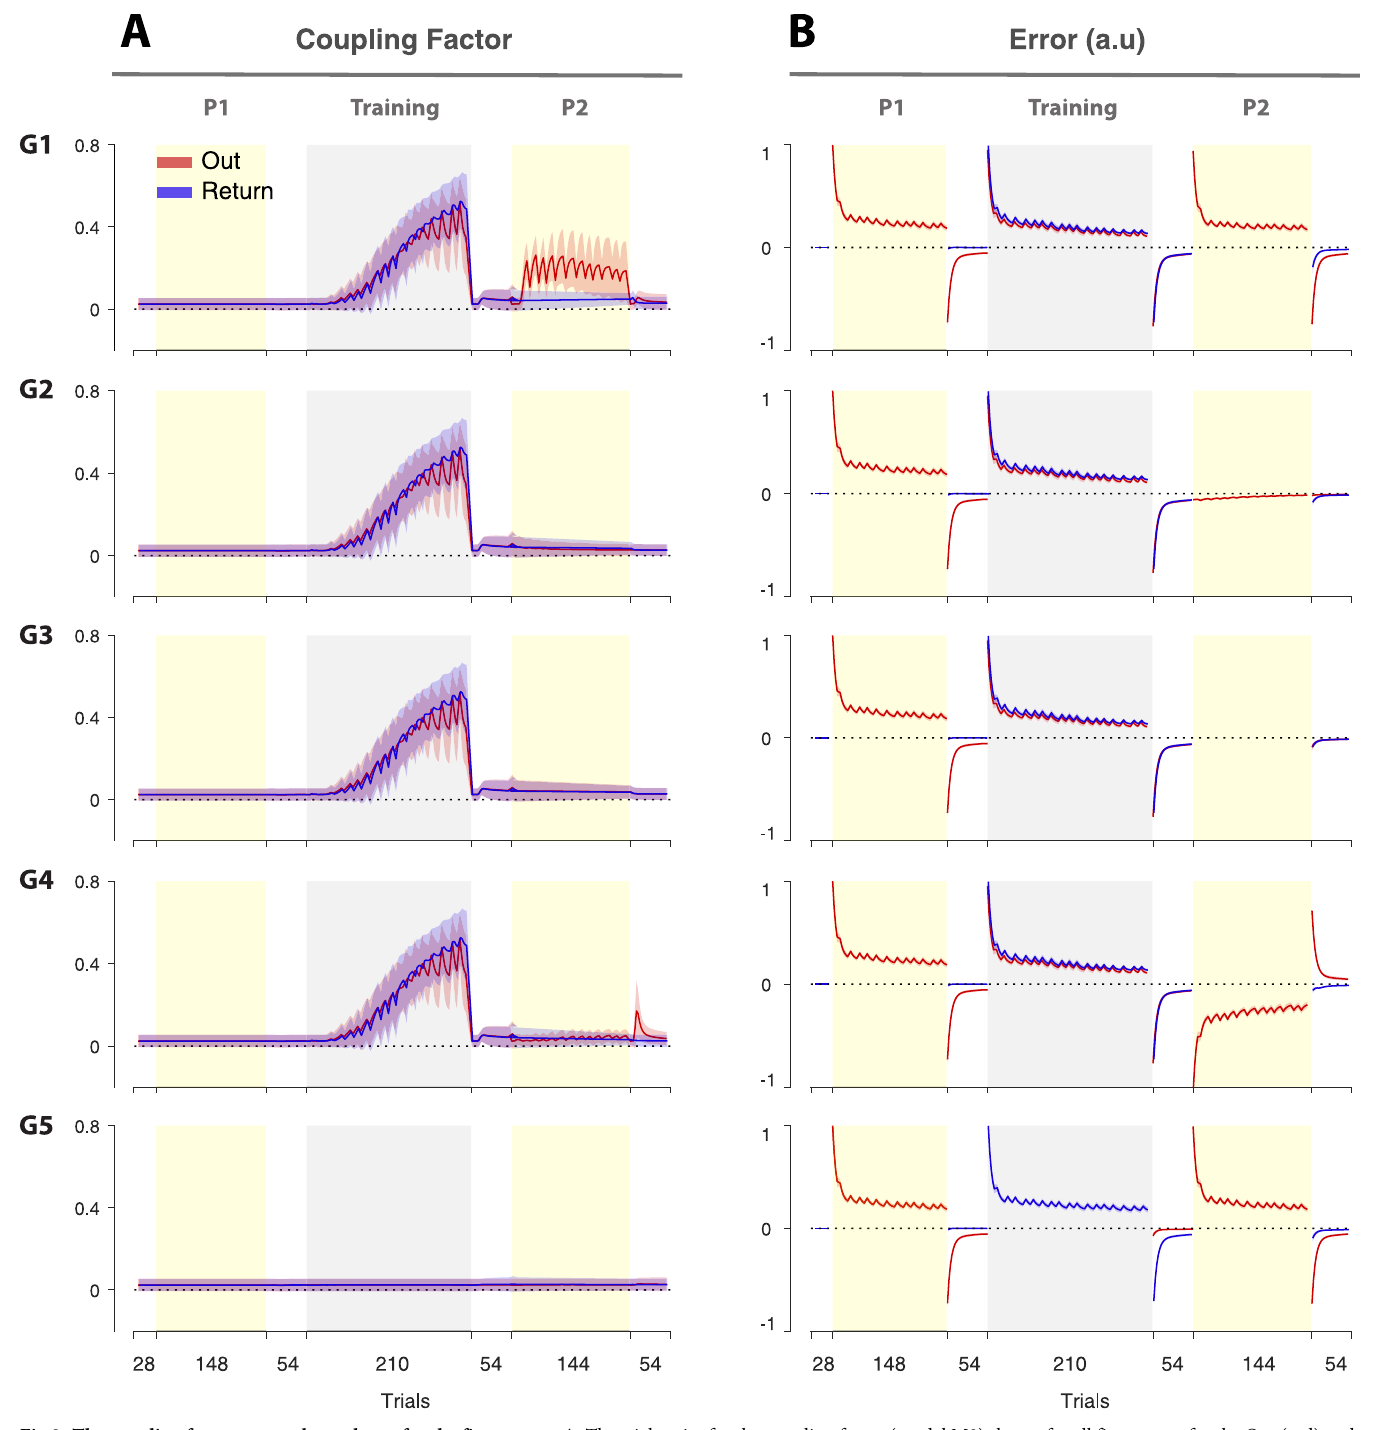
Fig 8. The coupling factor across three phases for the five groups. A . The trial-series for the coupling factor (model M8) shown for all five groups for the Out (red) and Return (blue) movements. The error bars represent the 95% confidence intervals, obtained by bootstrapping. B . The trial-series for error from the model for the Out (red) and Return (blue)